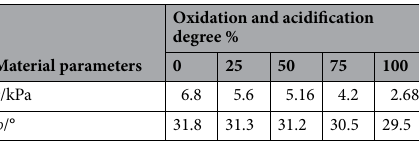
Table 3. Changes of mechanical parameters of tailings sand under different oxidation